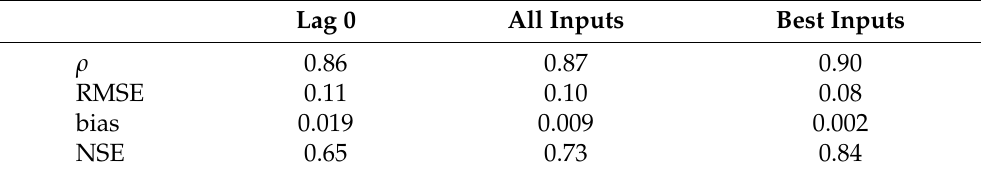
Table 4. Performance of Neural Network with all available input features compared to best input only.